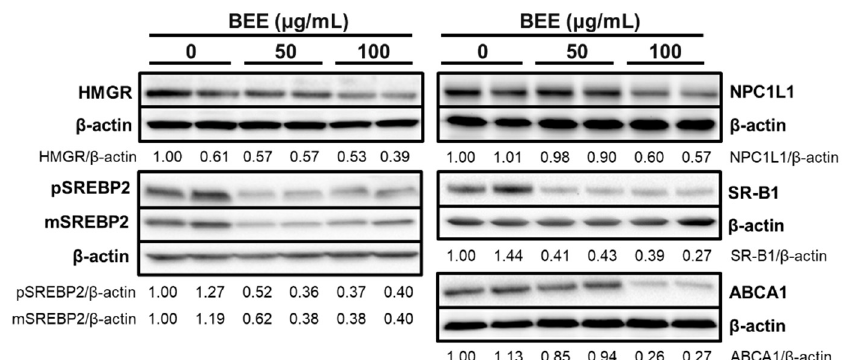
Figure 3. The effects of BEE on the proteins involved in cholesterol biosynthesis and absorption in Caco-2 cells. The cells were treated with 50 or 100 µ g/mL BEE for 24 h. The Western blot was conducted twice, and the representative image is shown. β -Actin was used as a loading control. Densitometry analysis was performed to measure the relative intensity, and the values are shown under each protein band.